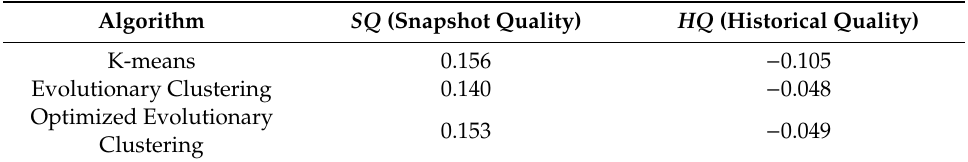
Figure 8. Nineteen days’ Snapshot Quality ( SQ ) and History Quality ( HQ ) of three algorithms in Shanghai dataset. Table 1. Quality